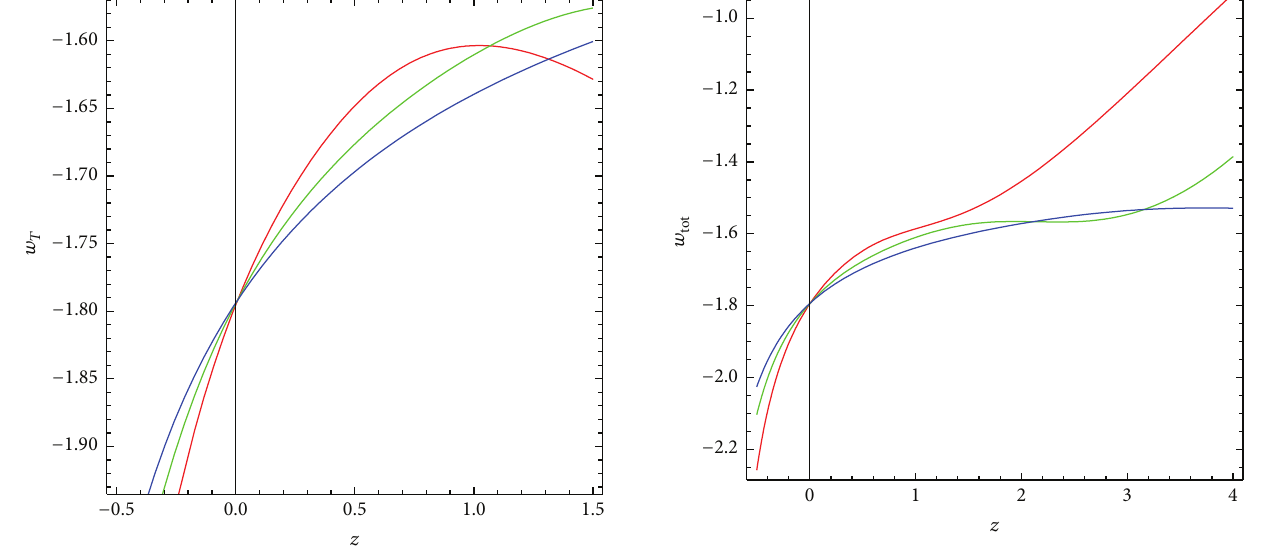
Figure 12: Effective torsion EoS parameter based on reconstructed ̇𝐻 in (63).